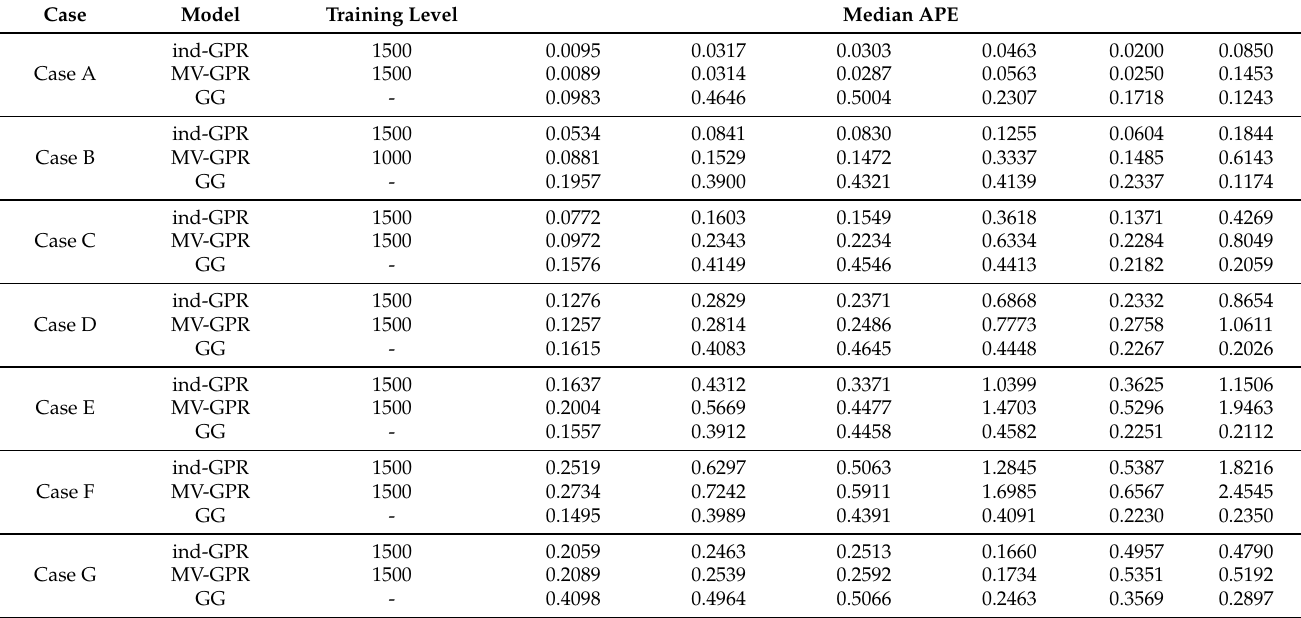
Table 3. Median APE for for most accurate model in each orbit case given perfect RA and DEC